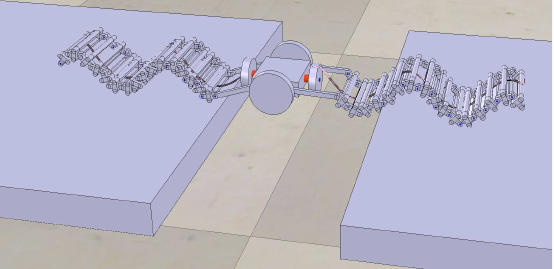
Figure 5. The robot improves its climbing capabilities in a gap-crossing scenario, with the introduction of a second